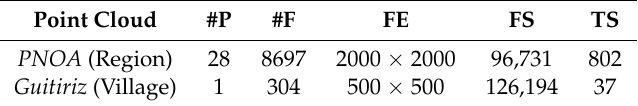
Table 1. Properties of the raw LiDAR point clouds selected for preprocessing. #P , Number of points (billions); #F , Number of files; FE , File extent (meters); FS , File size (average kilobytes per file); TS , Total point cloud size